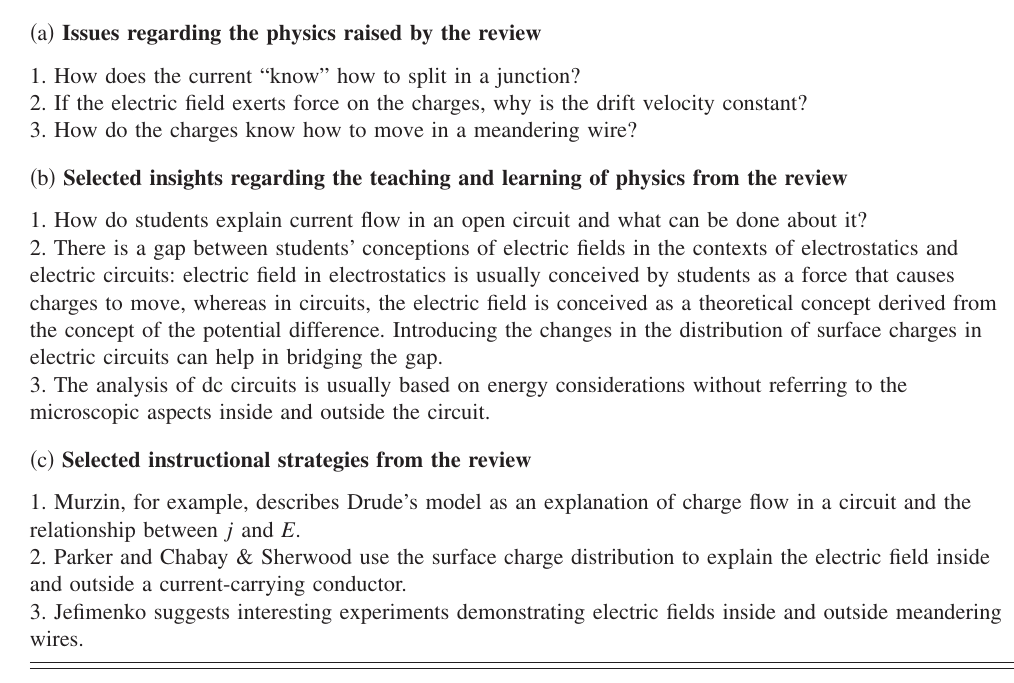
TABLE I. Teachers’ present their review of the literature. (cid:1) a (cid:2) Issues regarding the physics raised by the